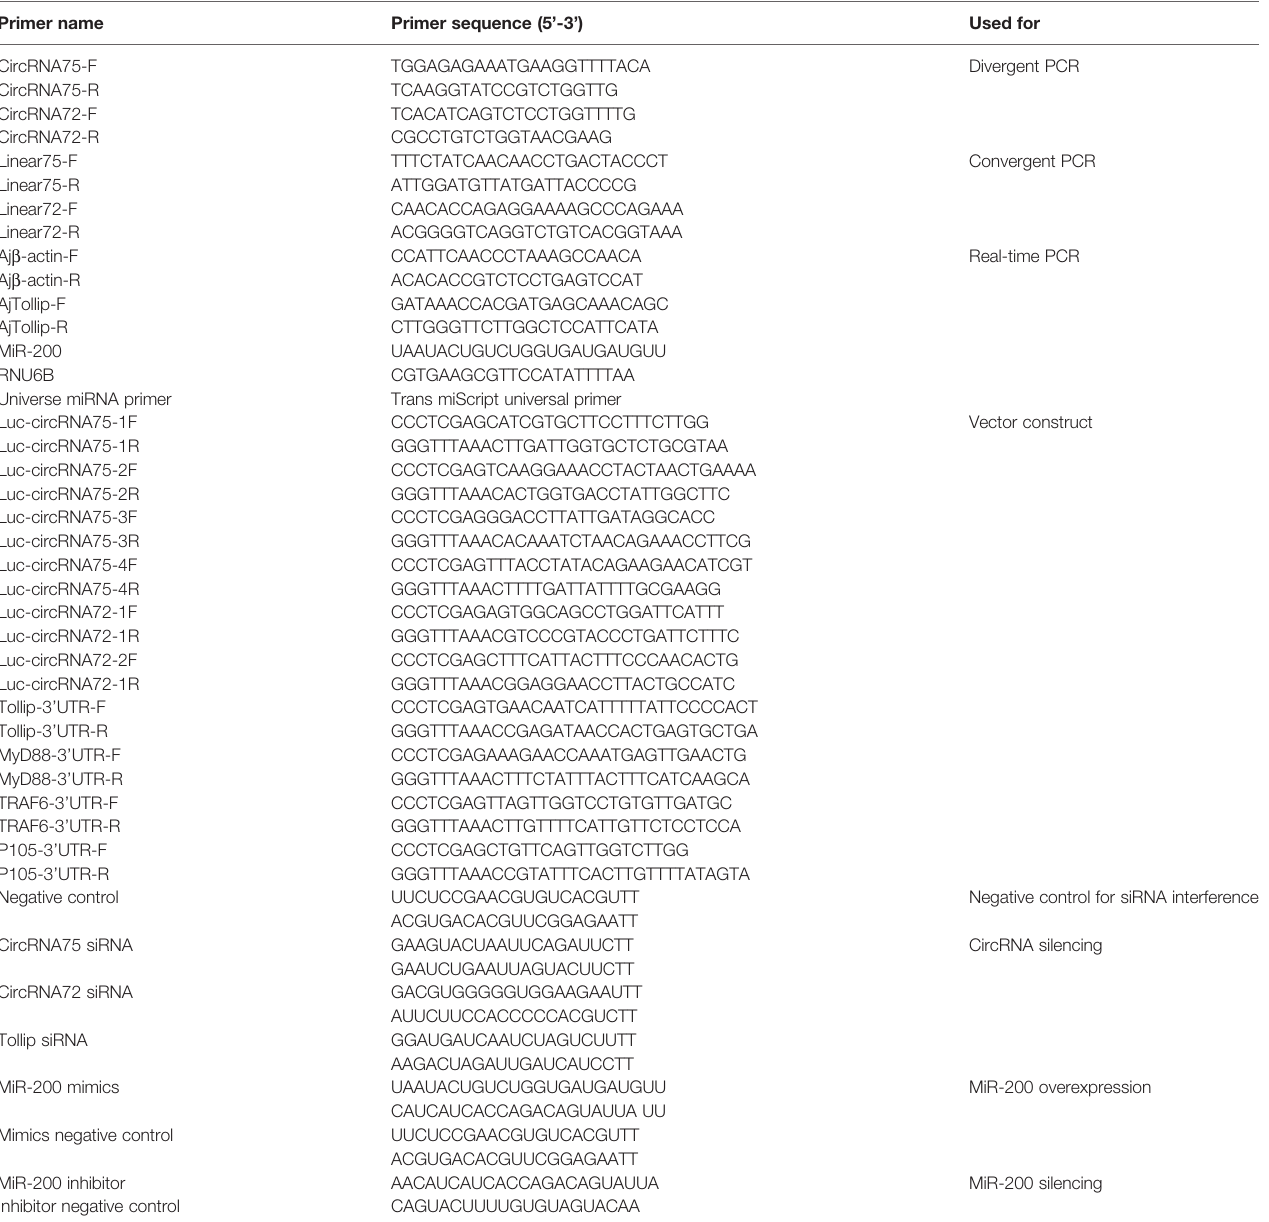
TABLE 1 | Primers used in this